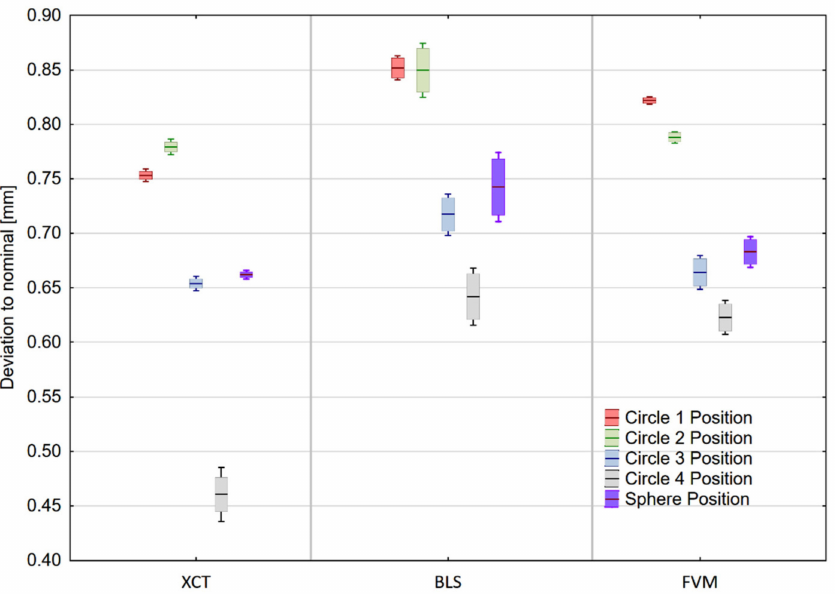
Figure 13. Positioning tolerances of fitted sphere and circles. Corresponding values of different elements are shifted for the purpose of data clarity. Box boundaries are equal to the standard deviation of the measurements, and whiskers represent the 95% Confidence Interval.